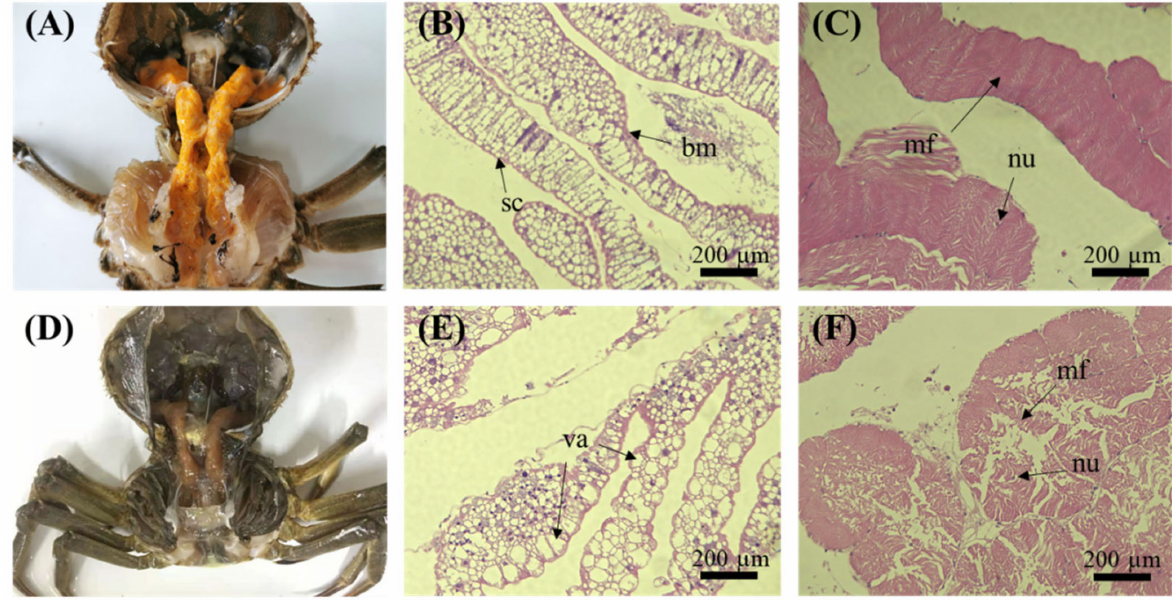
Figure 1. Healthy ( A ) and HPND-affected ( D ) E. sinensis. ( B ) and ( E ) represent the hepatic tubules of healthy and diseased crabs, respectively. ( C ) and ( F ) represent the appendage muscle tissue of healthy and diseased crabs, respectively. bm: basement membrane; nu: nucleus; mf: muscle fiber; va: vacuole; sc: secretory